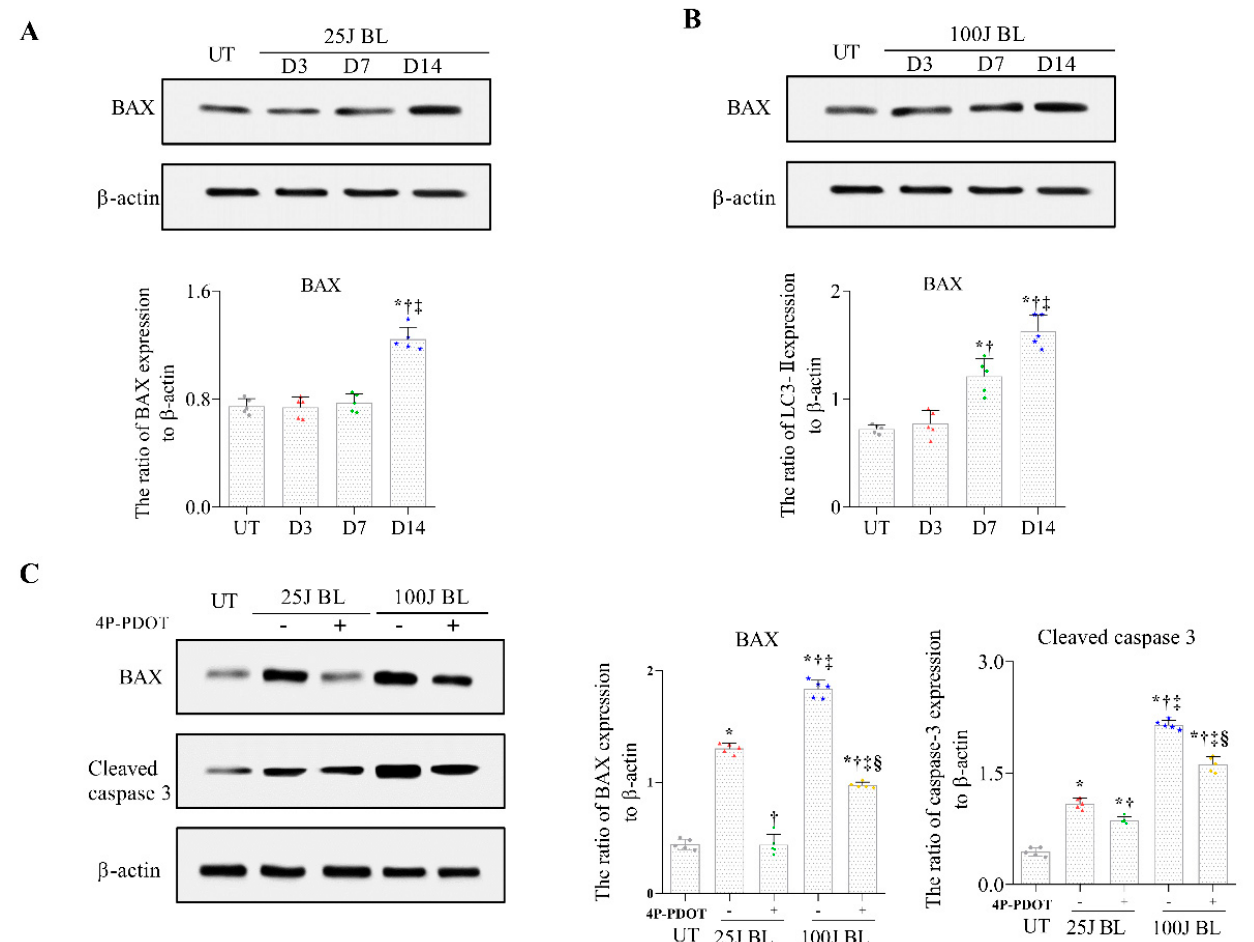
Figure 6. Western blotting ( A , B ) for BAX expression in the cornea of the UT, 25J BL, and 100J BL groups, on 3, 7, and 14 days of BL exposure. The expression of BAX and cleaved caspase-3 in the cornea of the UT, 25J BL, 25J BL+4P-PDOT, 100J BL, and 100J BL+4P-PDOT groups using Western blotting, after 14 days of BL exposure. ( A , B ) * p < 0.05 vs. UT, † p < 0.05 vs. D3, ‡ p < 0.05 vs. D7; ( C ) * p < 0.05 vs. UT, † p < 0.05 vs. 25J BL, ‡ p < 0.05 vs. 25J BL+4P-PDOT, § p < 0.05 vs. 100J BL; UT, untreated; BL, blue light.